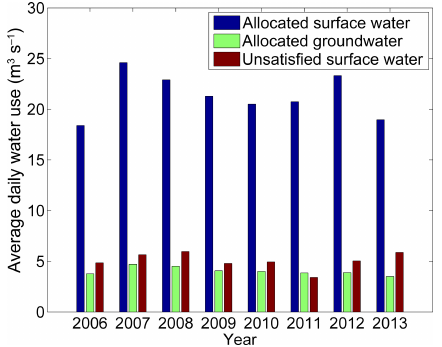
Figure 9. Average daily allocated surface water, groundwater, and unsatisfied surface water use for each